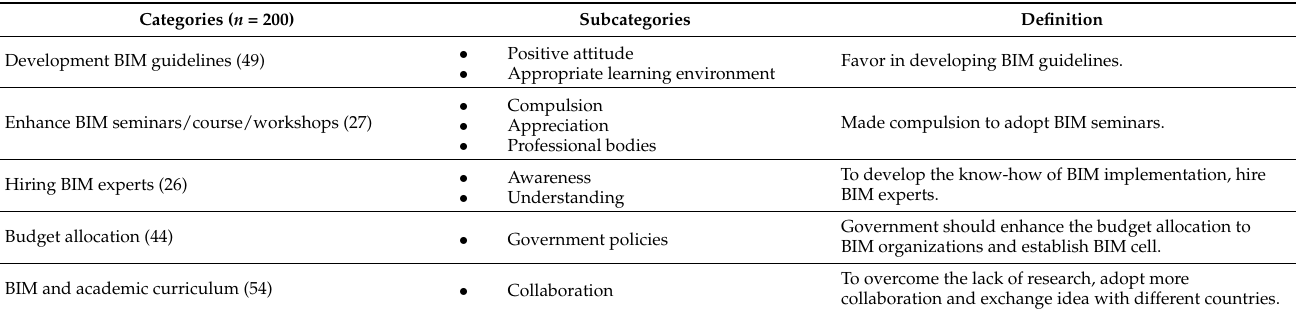
Table 3. Coding theme and appropriate